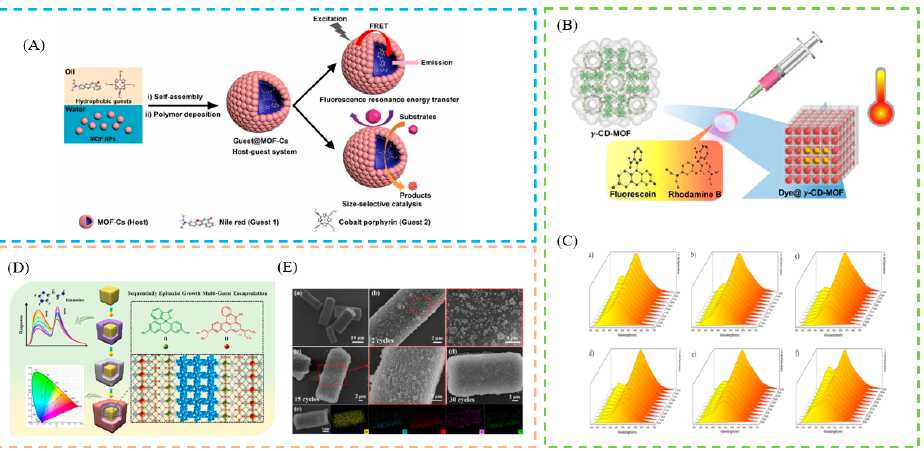
Figure 2. ( A ) Schematic description of the fabrication process of MOF-Cs. ( B ) Schematic